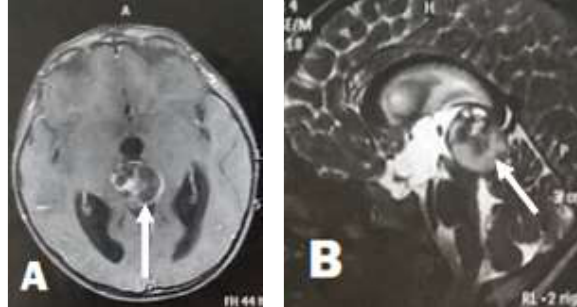
Figure. 1 – Pineal region mature teratoma (white arrow) A - Axial T1-weighted after gadolinium and B – Sagital T2-weighted magnetic resonance (MR) images